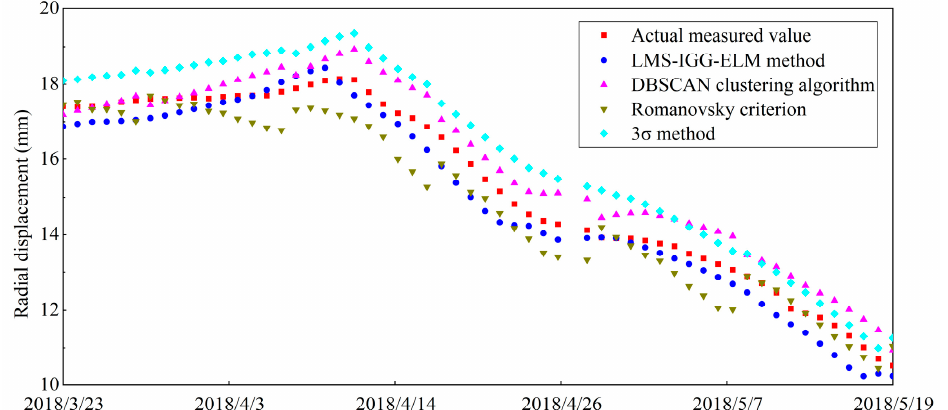
Figure 10. Dam monitoring model after eliminating gross errors by the 3 σ method.